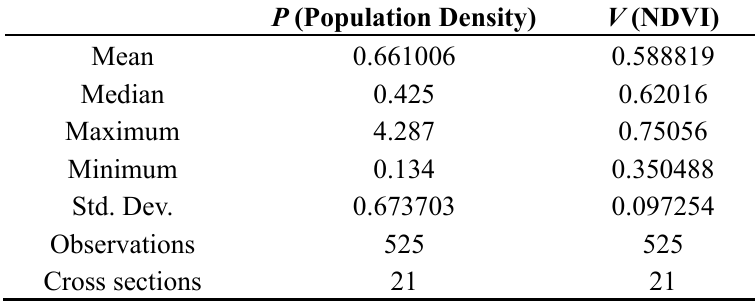
Table 1. Descriptive statistics of population density and annual maximum NDVI data of 21 cities in Guangdong Province during the period from 1982 to